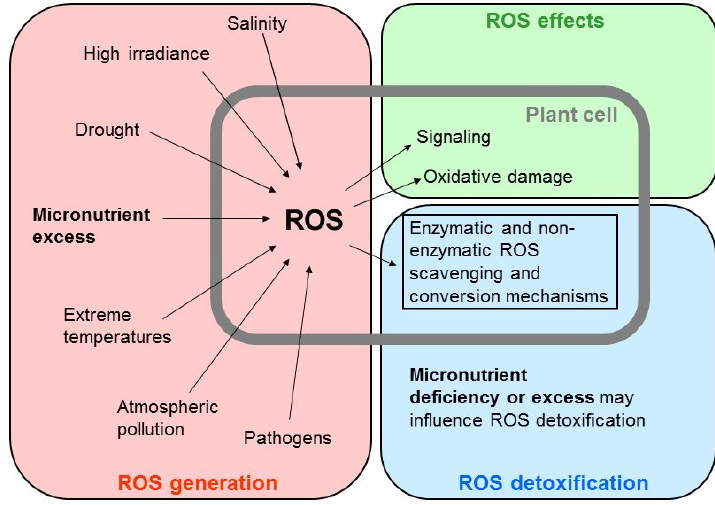
Figure 1. Involvement of micronutrients (e.g., Fe, Mn, Zn, Cu and Ni) in the generation and detoxification of ROS in plant cells under abiotic and biotic stress. Micronutrient deficiency and excess influence ROS levels and as a consequence damages caused by